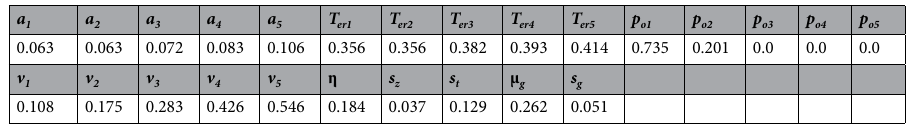
Table 1. Diffusion model parameters for the guessing model. The numerical index for boundary separation ( a ), nondecision time ( T er ), and fast guess proportions ( p o ) represent speed accuracy conditions, 1 for extremely fast, 2 for fast, 3 for medium, 4 for slow, and 5 for extremely slow. The numerical index for drift rate ( v ) represents the contrast (difficulty) manipulation, 1 for the lowest contrast and 5 for the highest. The SD in drift across trials is η, the range of the distribution of starting point is s z , the range of the distribution of nondecision times is s t , the mean of the normal distribution of guesses is μ g and the SD in the distribution of guesses is s g